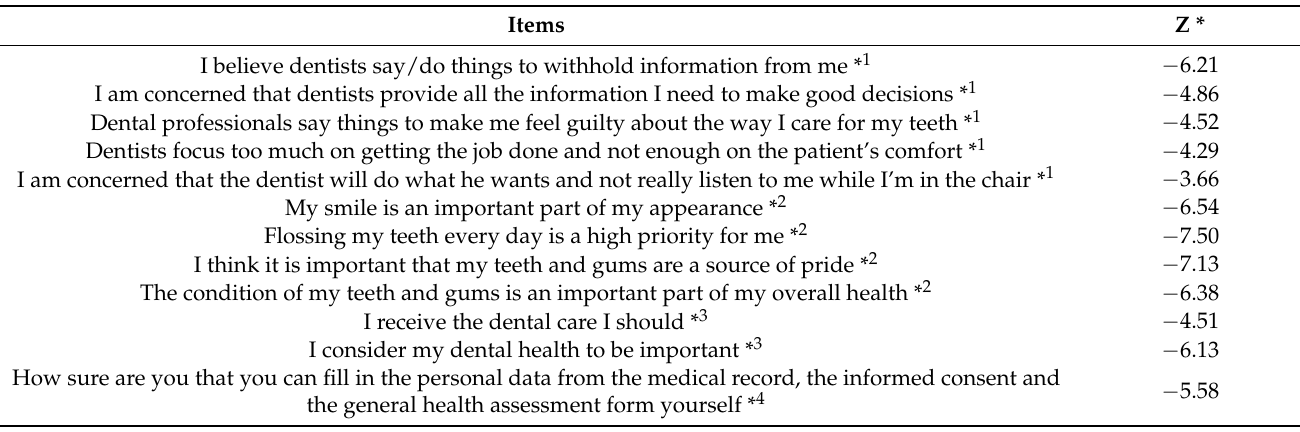
Table 4. Gender differences in terms of